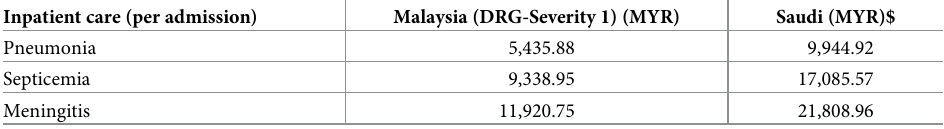
Table 3. Cost estimations for inpatient care to treat pneumococcal disease in 2017 based on My-DRG. Inpatient care (per admission)